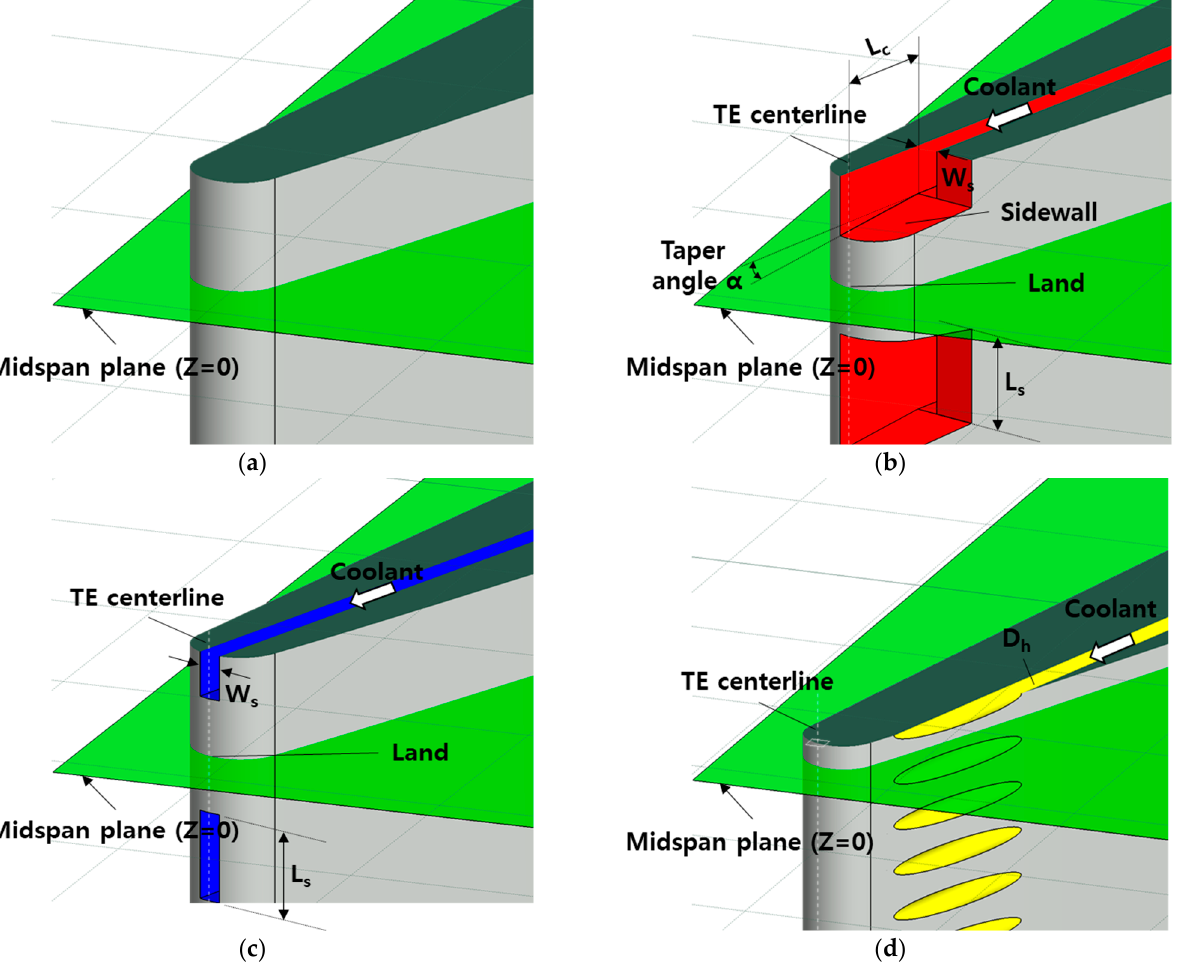
Figure 2. The schematic of the various trailing edge cooling schemes: ( a ) solid(baseline); ( b ) cutback slot; ( c ) central injection slot; ( d ) pressure side hole.